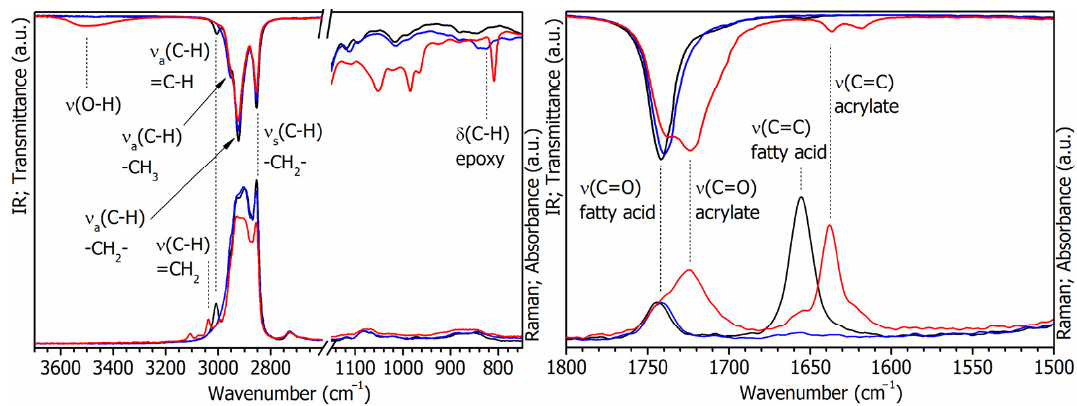
Figure 3. Vibration spectra of ME_OA (black), EME_OA (blue), and AME_OA (red).